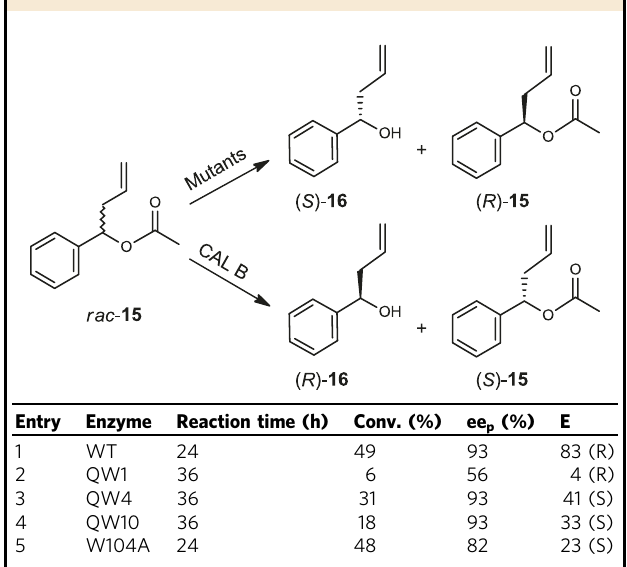
Entry Enzyme Reaction time (h) Conv. (%) ee p (%)